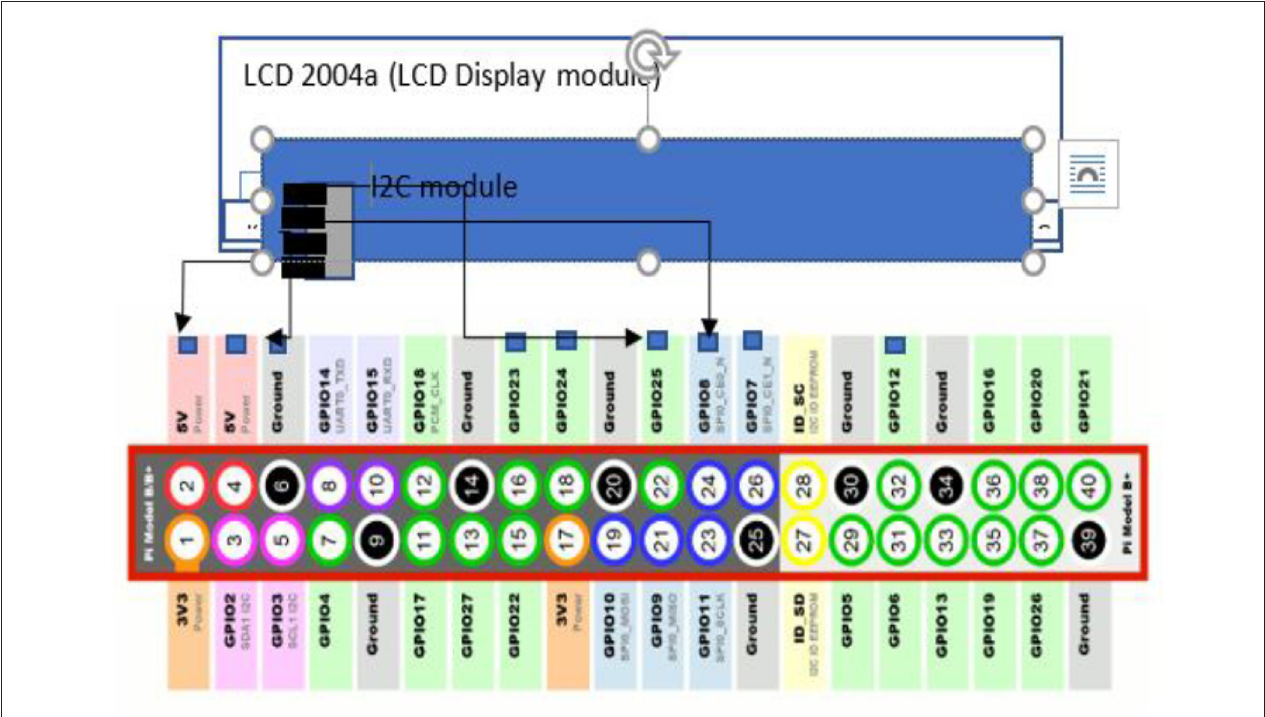
FIGURE 6 | Interfacing of 2004a display LCD with Raspberry